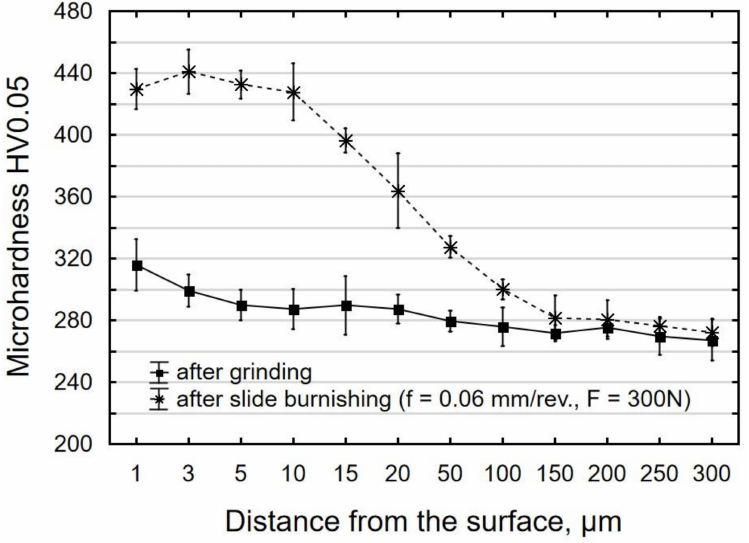
Figure 12. Distribution of microhardness on the surface layer of samples after grinding (pre-treatment) and slide